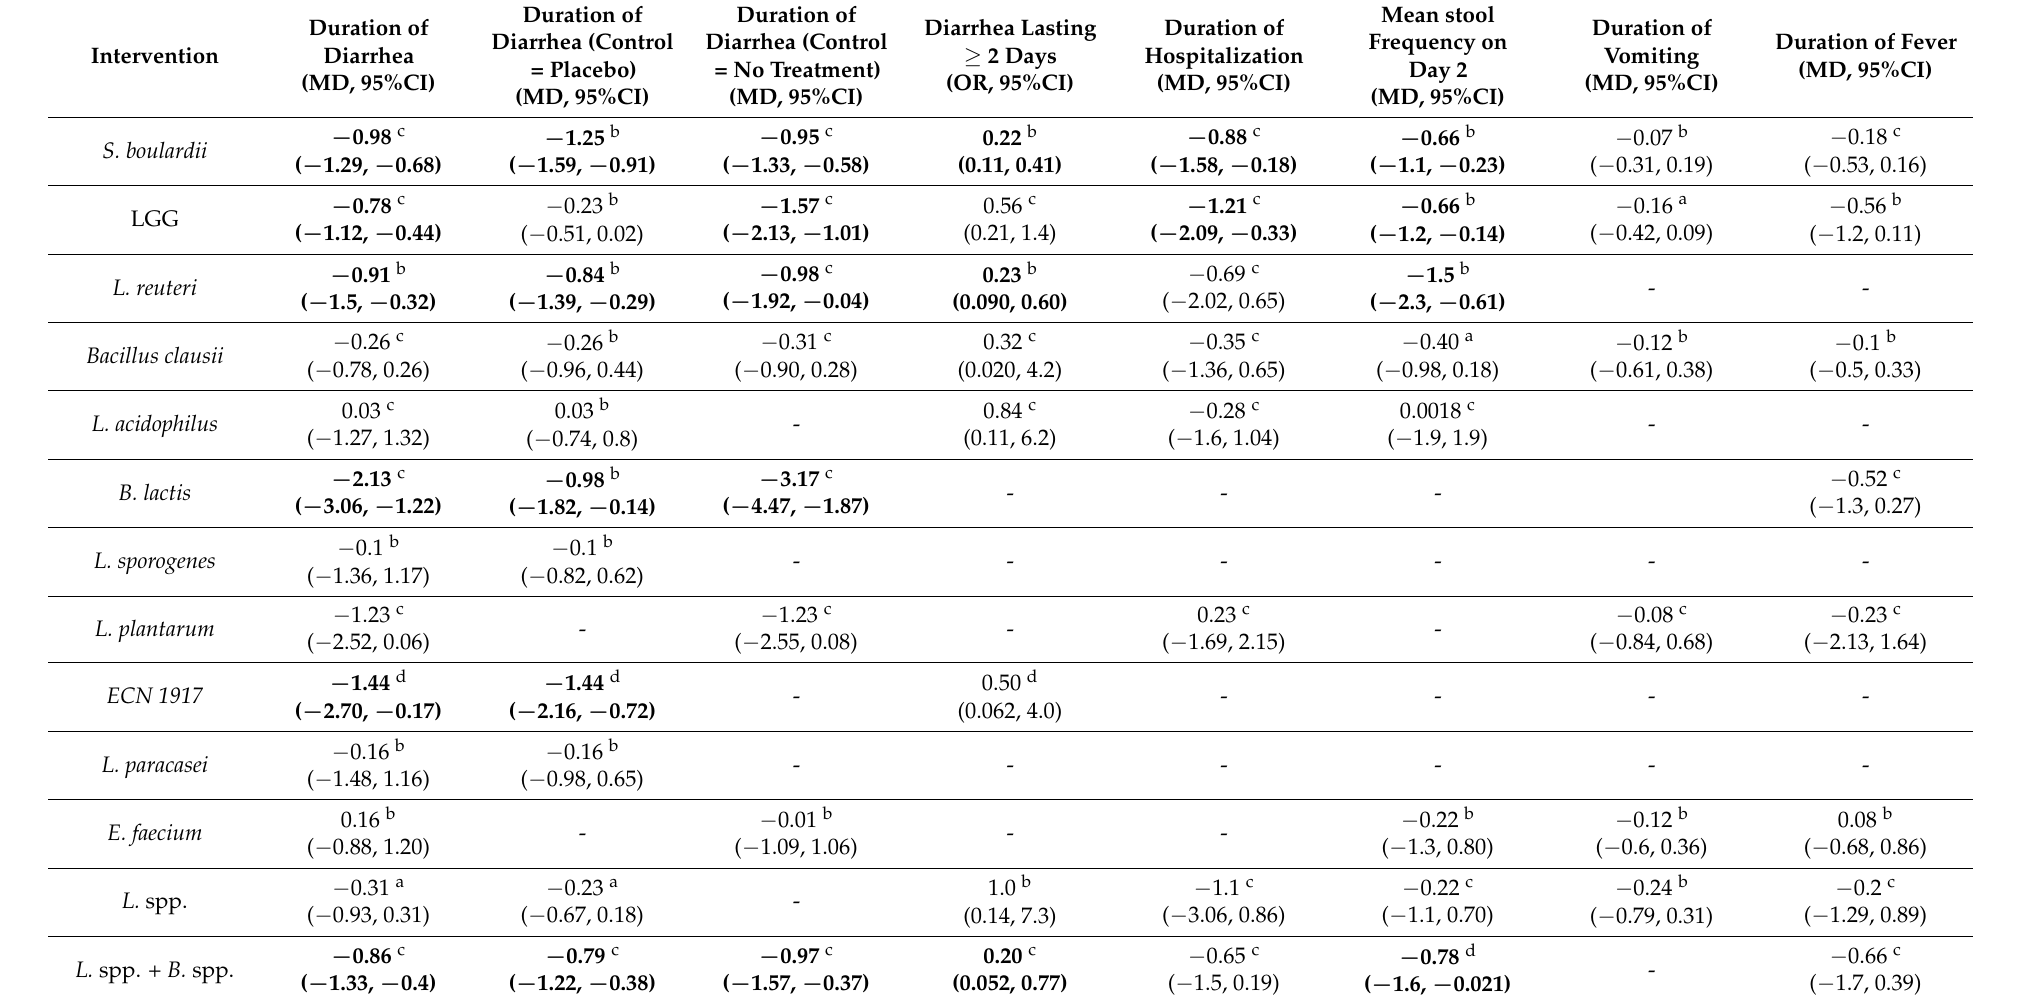
Table 1. Results of comparisons of interventions for each outcome in the network